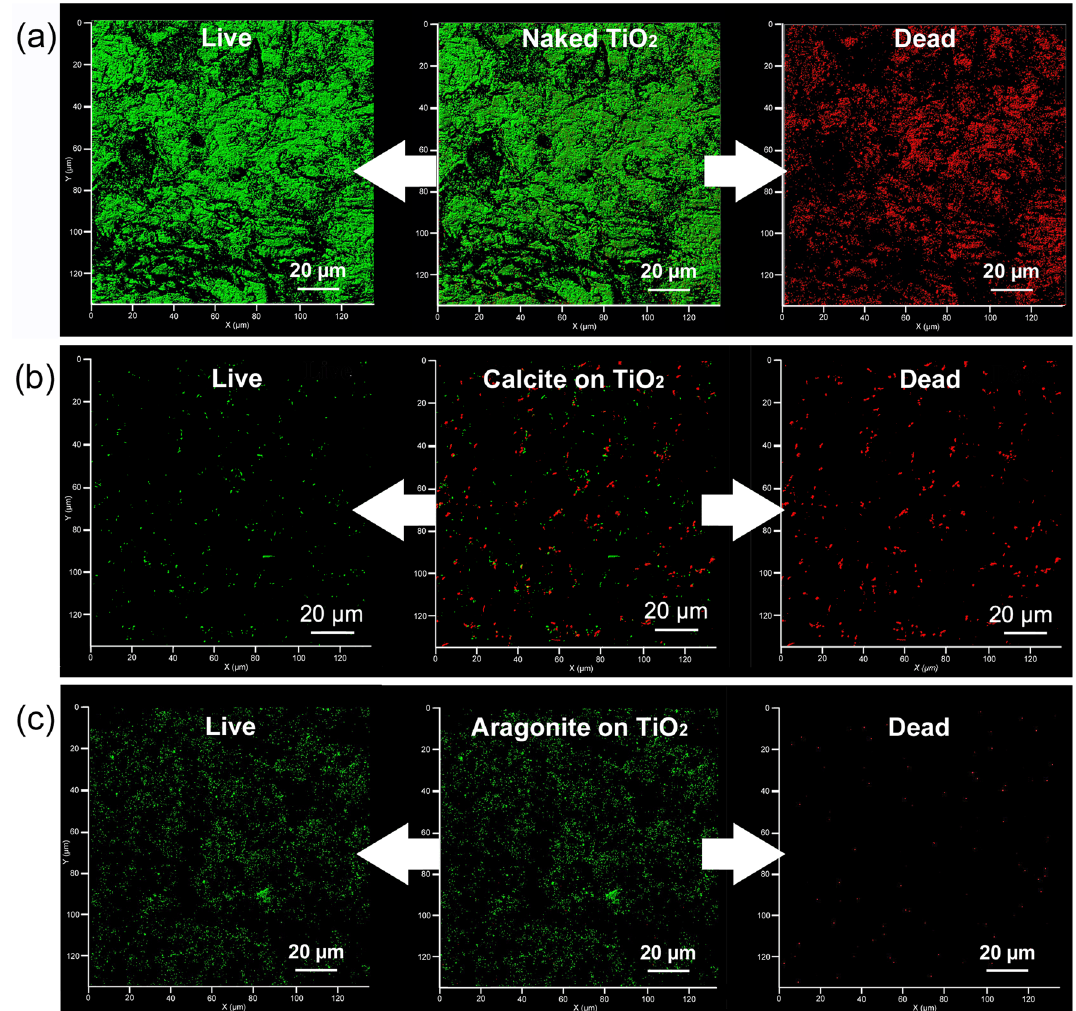
Figure 6. Observations of mechano-bactericidal effects in circulation systems. ( a ) Confocal microscopy images of stained E. coli on an unmodified TiO 2 ceramic surface. ( b ) Confocal microscopy image of stained E. coli cells on a calcite-modified TiO 2 ceramic surface. ( c ) Confocal microscopy image of stained E. coli on an aragonite- modified TiO 2 ceramic surface. The L/D composite image is shown in the center, and the distribution of live and dead bacteria is shown on the left and right,